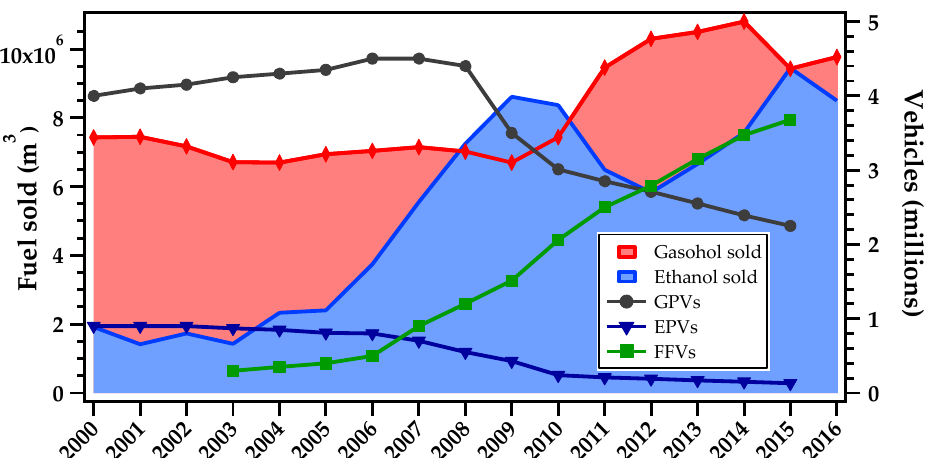
Figure 1. Annual evolution of the amount of fuel sold (in millions of cubic meters) [17], for gasohol (red shaded area) and hydrous ethanol (blue shaded area), as well as of the numbers of gasohol-powered vehicles (GPVs, black line) [9], ethanol-powered vehicles (EPVs, blue line), and flex-fuel vehicles (FFVs, green line) in the Metropolitan Area of São Paulo (2000–2016).